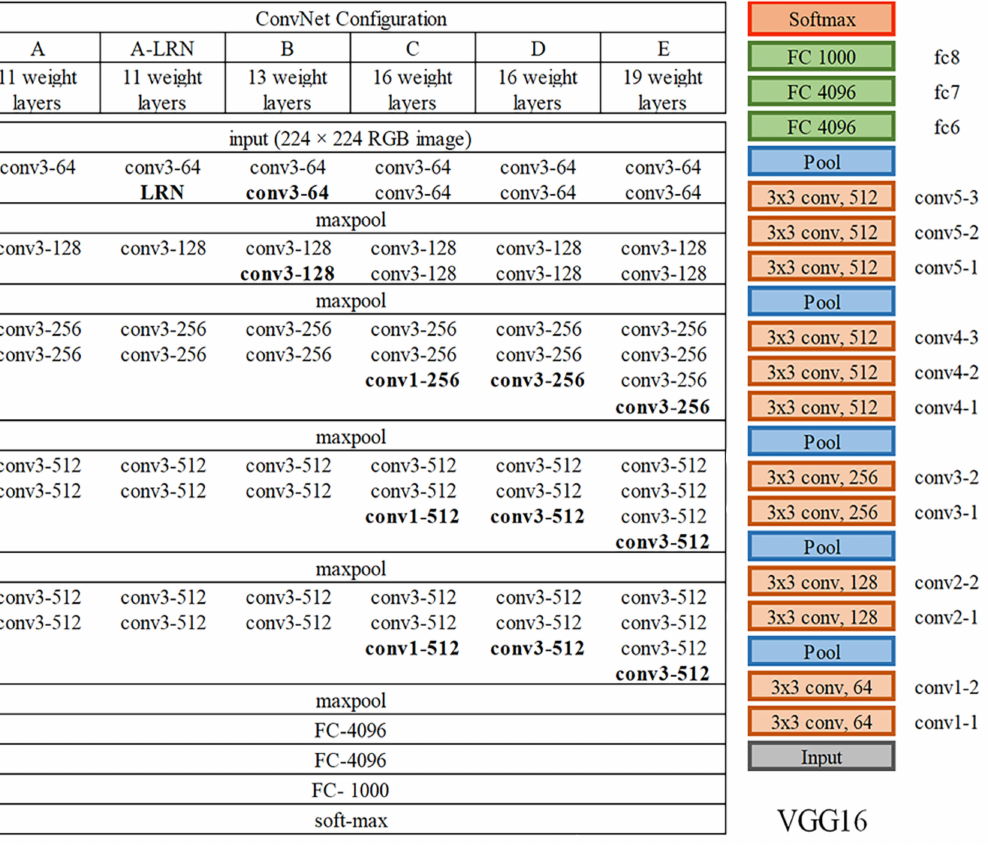
Figure 9. Structure of our visual geometry group network-16 (VGG-16)